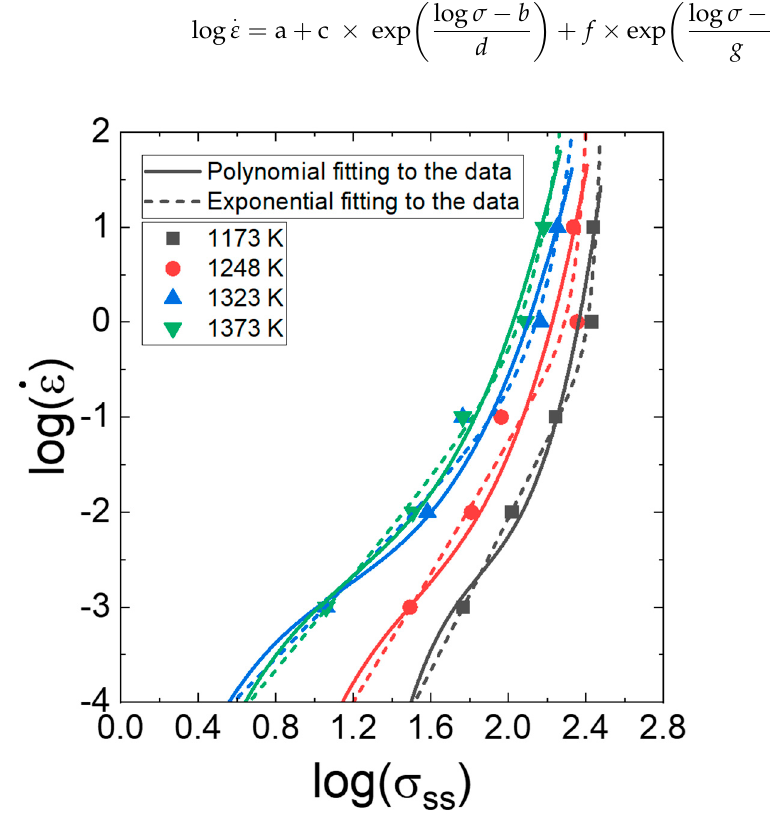
Figure 8. Polynomial fitting and exponential fitting to the data points in the plot in Figure 3a. Reproduced/modified with permission from [63], Elsevier.